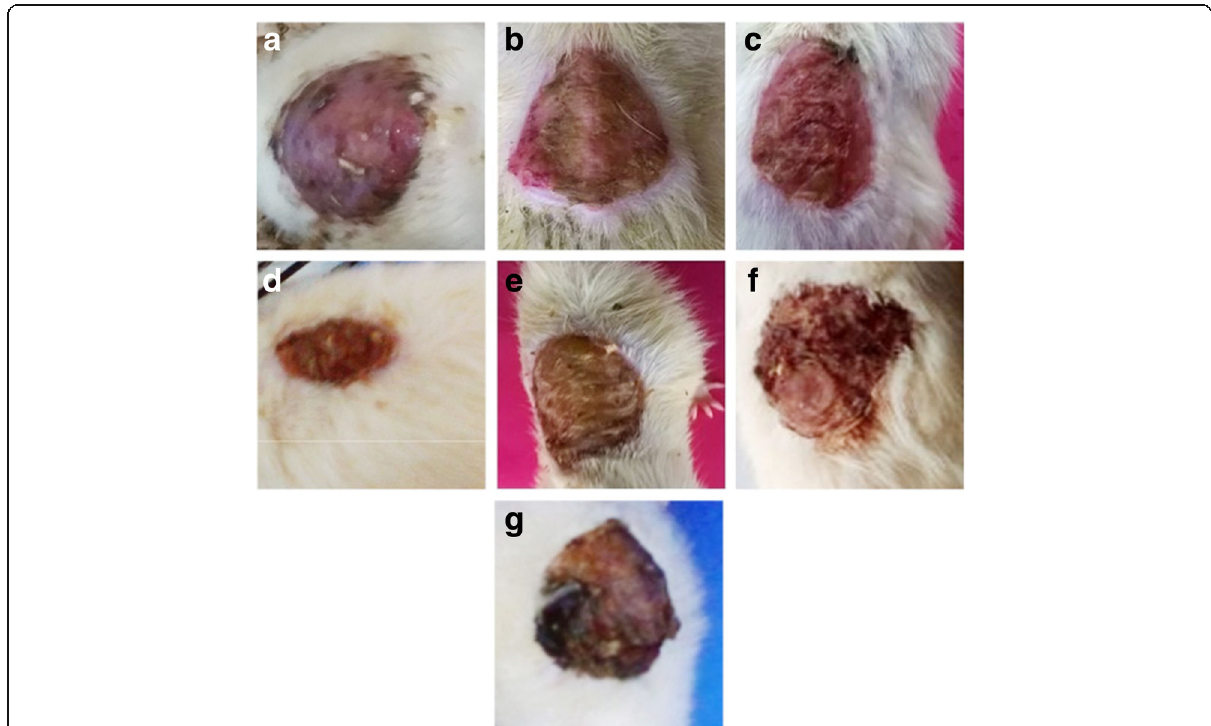
Fig. 2 Photographic representation of effect of E. hita on the wound contraction at the end of the study showing wound healing after oral and topical treatment at the end of the study. a : Group II = Diabetic wound control, b : Group III = Diabetic wound control +100 mg ethanolic extract of E. hirta , c : Group IV = Diabetic wound control +200 mg ethanolic extract of E. hirta , d : Group V = Diabetic wound control +400 mg ethanolic